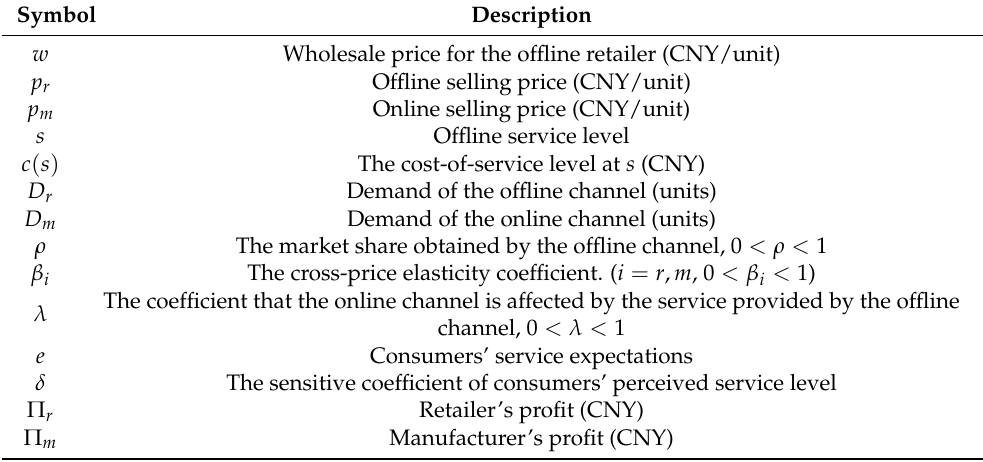
Table 1. List of